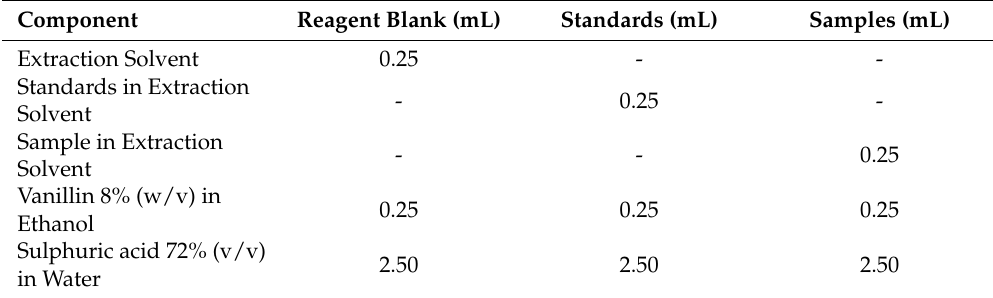
Table 1. The vanillin-sulphuric acid assay setup procedure. Component